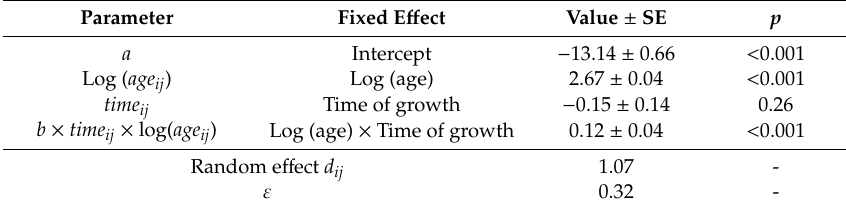
Table 6. Results of the linear mixed model on the annual basal area increment (mm 2 yr − 1 ) of all analyzed trees (response variable) with the individual tree coded as random e ff ect, and the fixed e ff ects were log (age), time of growth (period before 1960 and period since 1960) and their interaction.